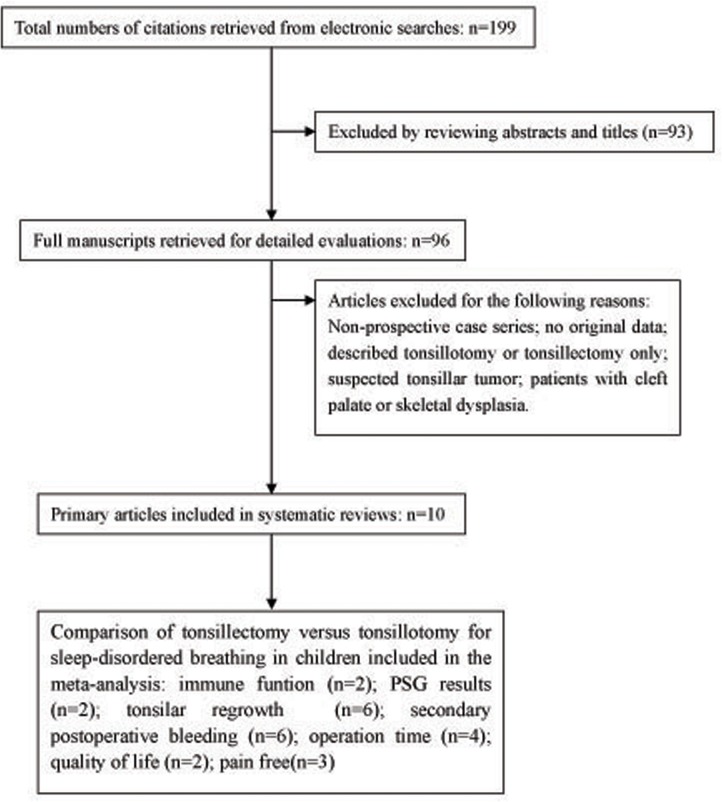
Search methodology.